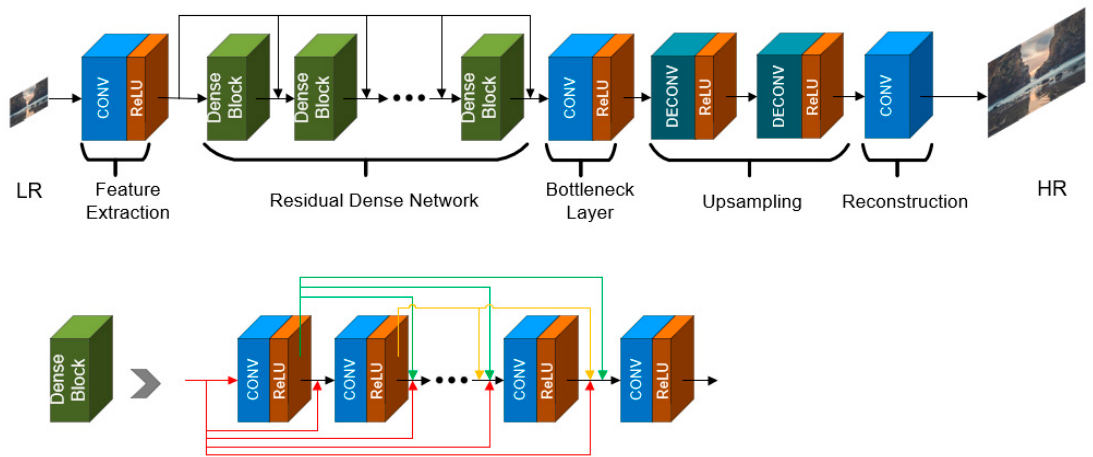
Figure 15. SRDenseNet network structure.